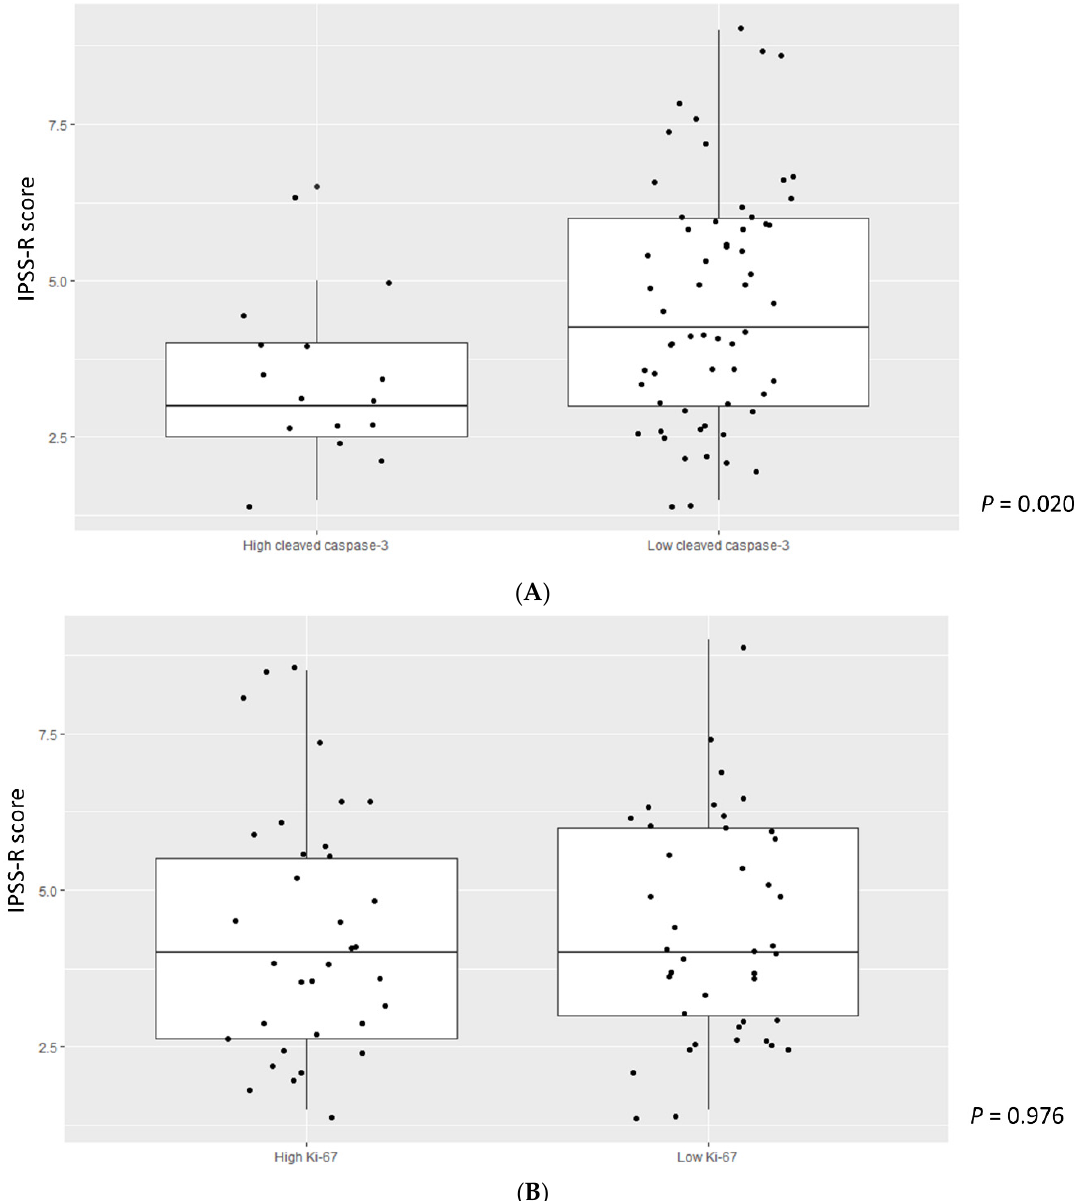
Figure 2. ( A ) IPSS-R score according to cleaved caspase-3. Abbreviation: IPSS-R, Revised international prognostic scoring system. ( B ) IPSS-R score according to Ki-67. Abbreviation: IPSS-R, Revised international prognostic scoring system1.